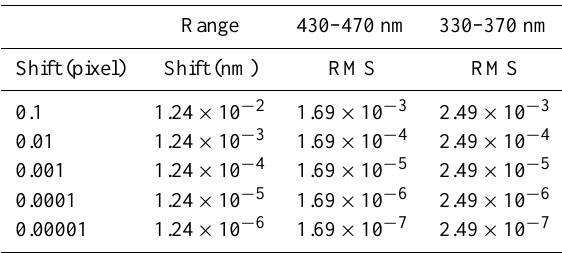
Table 3. Calculated RMS noise as a function of shift imprecision for two wavelength